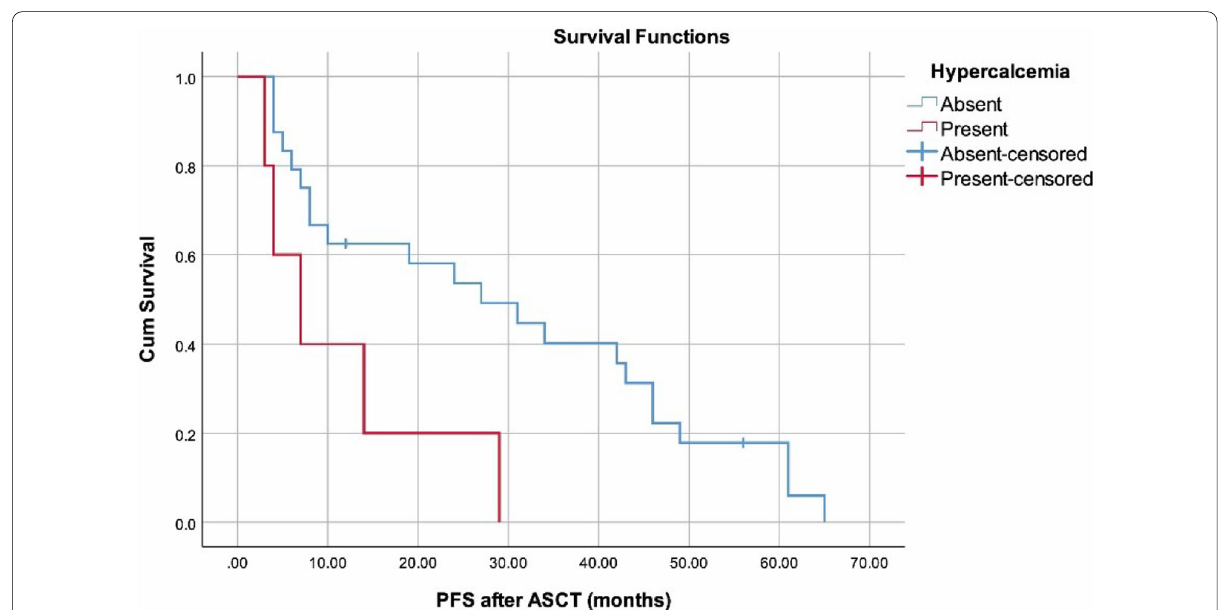
Fig. 7 Progression-free survival after autologous stem cell transplantation by